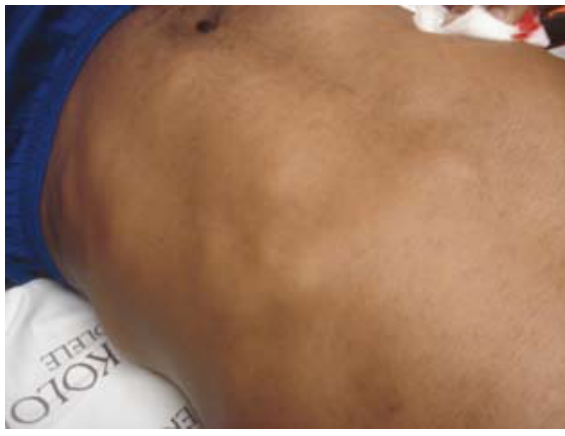
Fig. 1. Multiple lipomas on the patient’s